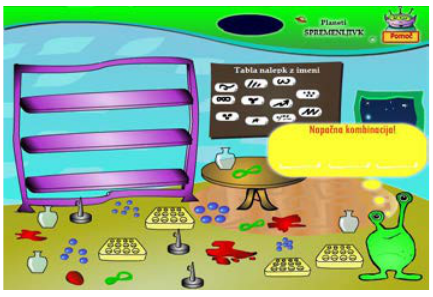
Figure 3. First game – Cleaning the mess Transporters